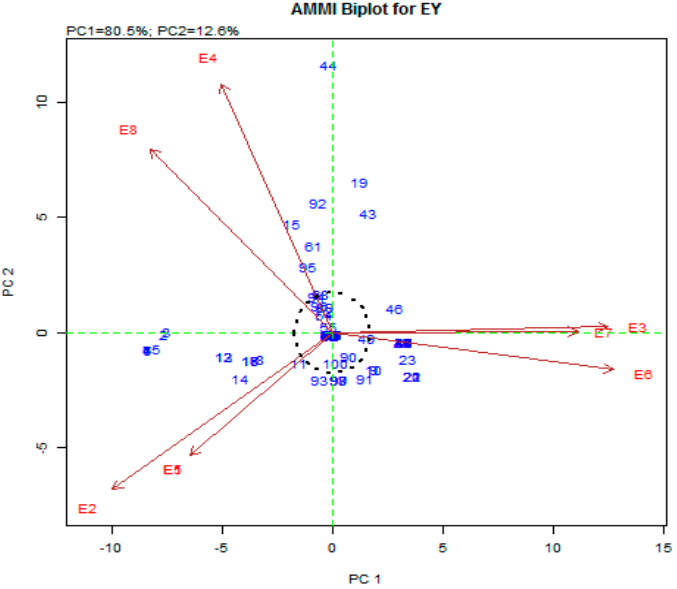
Figure 2. AMMI 2 biplot for grain yield per plot showing interaction of IPCA (Interaction Principal